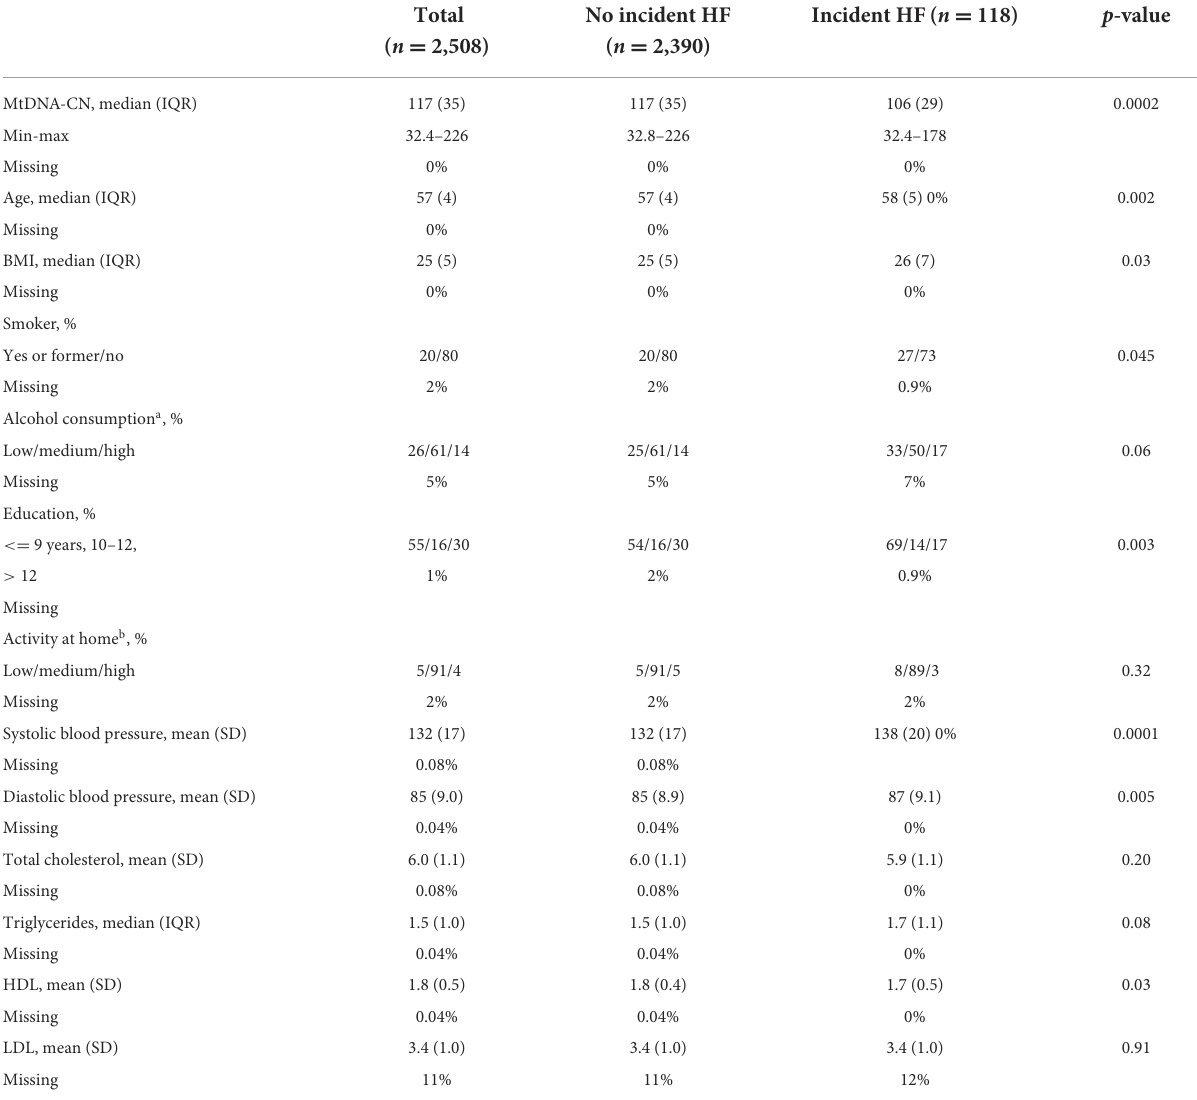
TABLE 1 Baseline characteristics for all individuals with a mtDNA-CN measure, stratified by no heart failure and incident heart